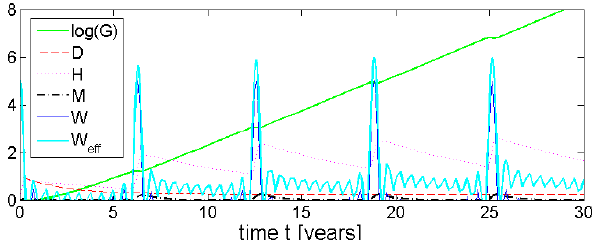
Figure 2. A simulation of the key dynamics of Viglione et al. (2014) given the continuous water function. It shows economic wealth G , distance D , height of levees H , memory M , basic water level W and effective water level W eff